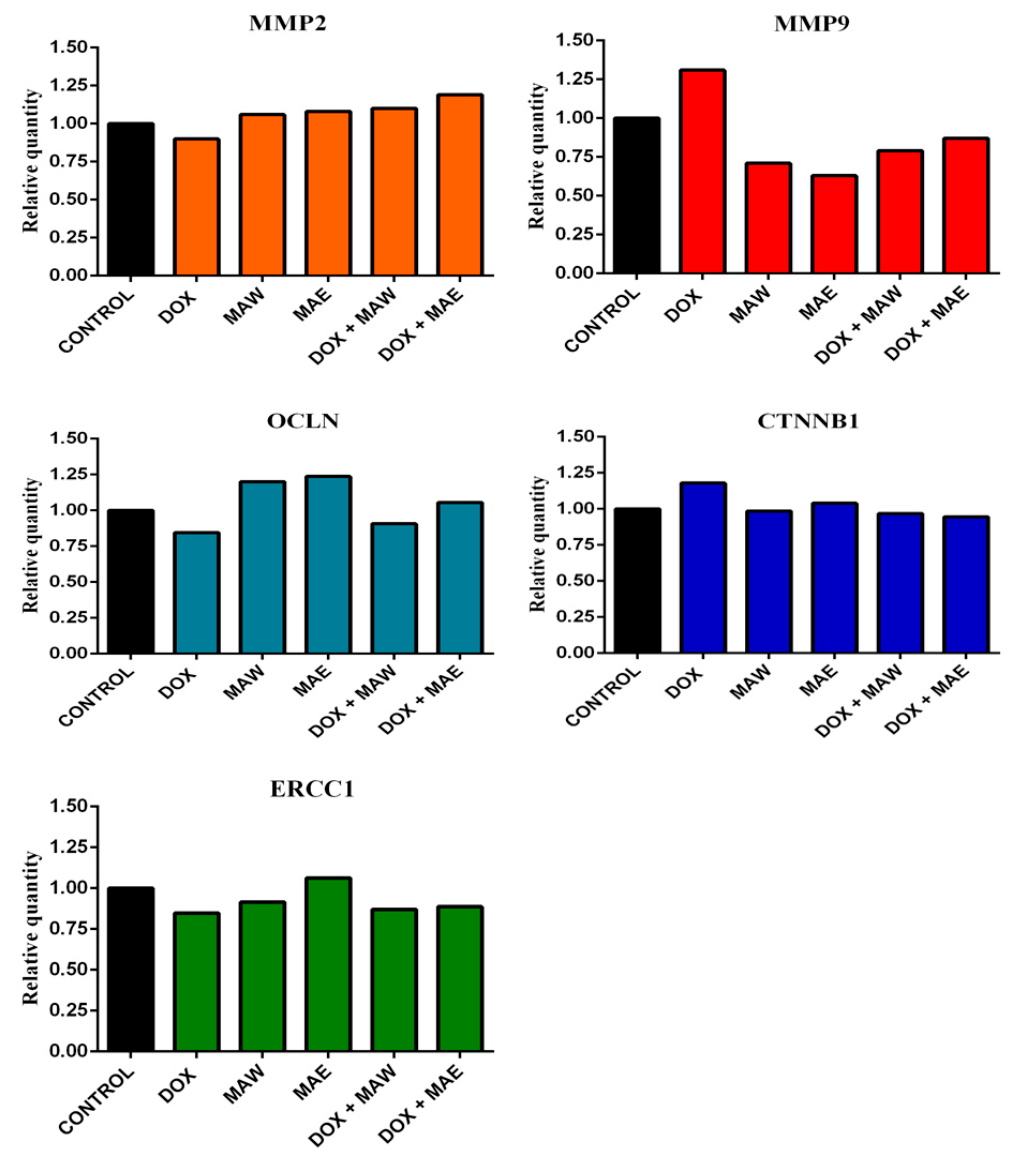
Figure 4. E ff ects of DOX IC20, MAE (20 µ g / mL), MAW (20 µ g / mL), or their combinations on Figure 4. Effects of DOX IC20, MAE (20 μ g/mL), MAW (20 μ g/mL), or their combinations on gene gene expression.